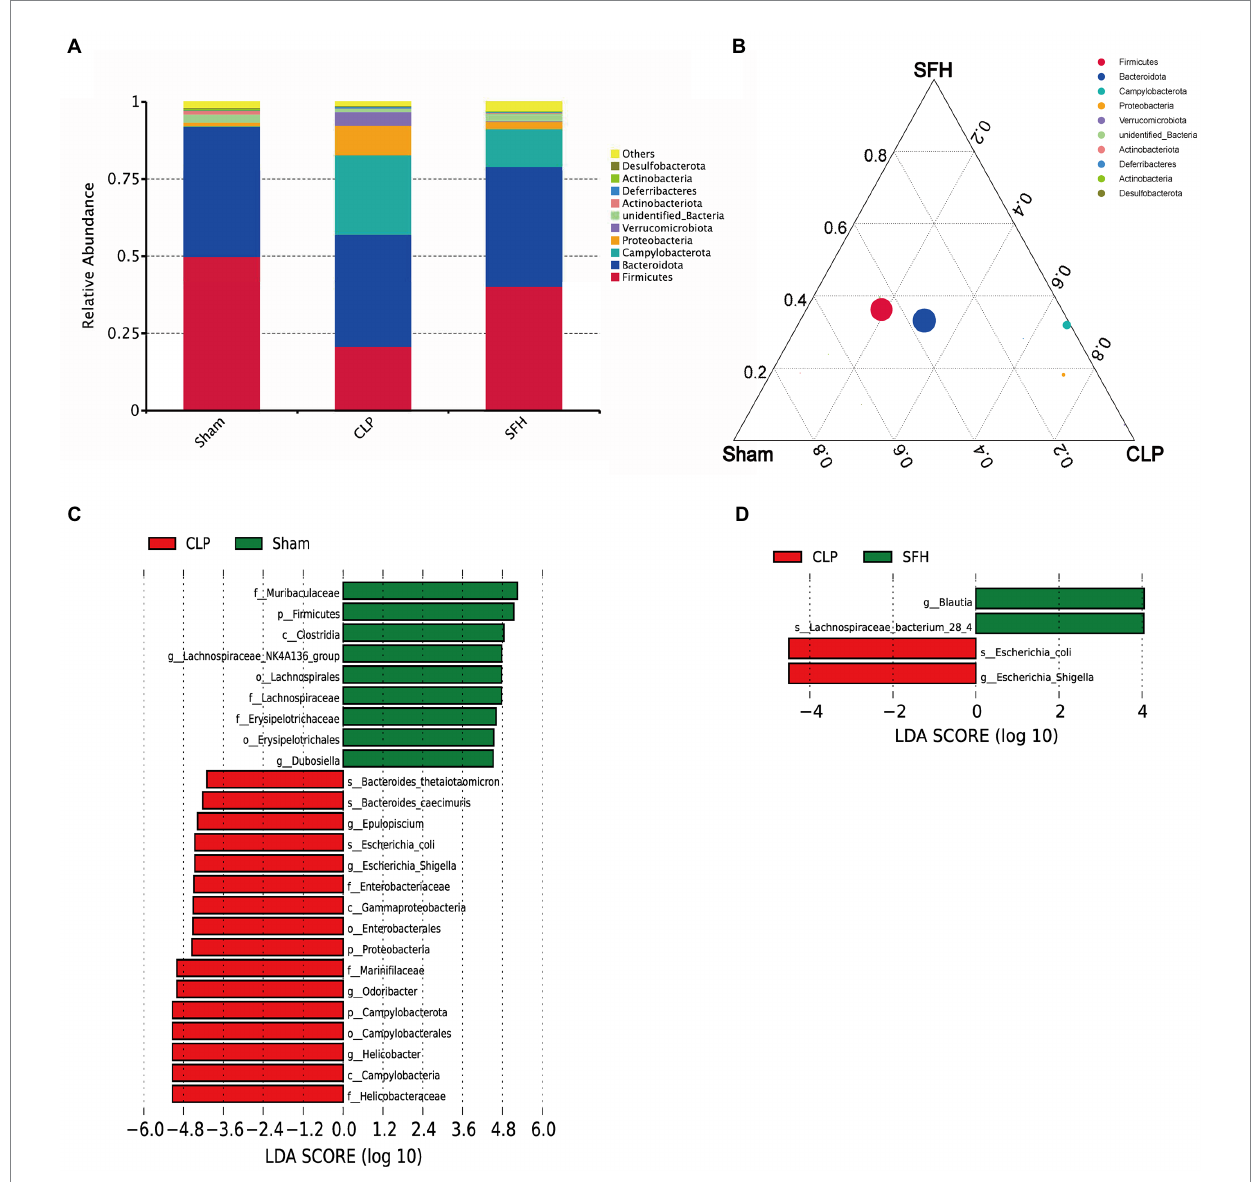
FIGURE 4 SFH changed the composition of gut microbiota in septic mice. (A,B) The phyla comparison among the groups of Sham, CLP, and SFH. (C) LEfSe analysis of Sham vs. CLP. (D) LEfSe analysis of CLP vs. SFH ( n = 7 per